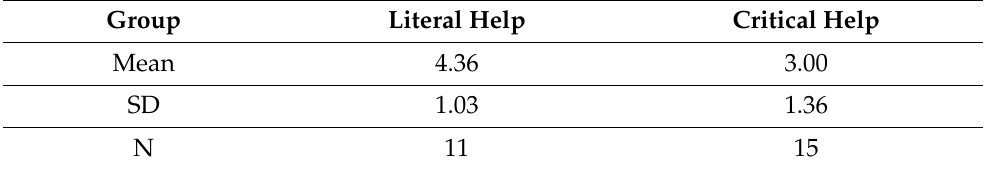
Table 3. Independent t -test conducted in order to answer RQ1. Please notice that there is a significant difference between the means of the two groups: the p -value is p =